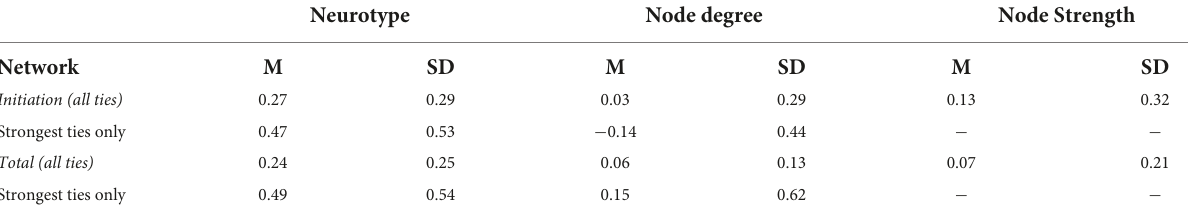
TABLE 4 Assortativity coefficients by neurotype, node degree, and node strength.